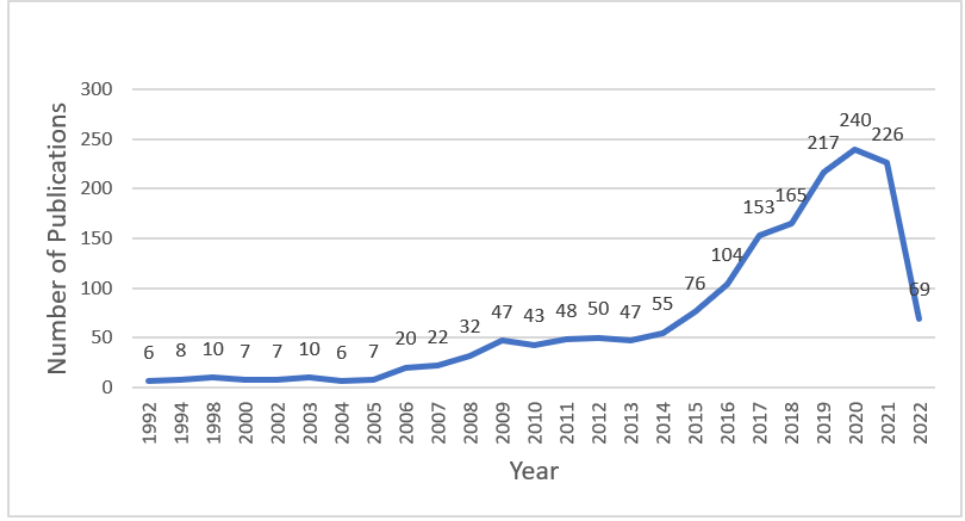
Figure 1. The number of published papers on the topic “ leadership in the construction industry ” or “ leadership in construction projects ” (1992 – 2022). Source: Web of Science . “leadership in construction projects” (1992–2022). Source: Web of